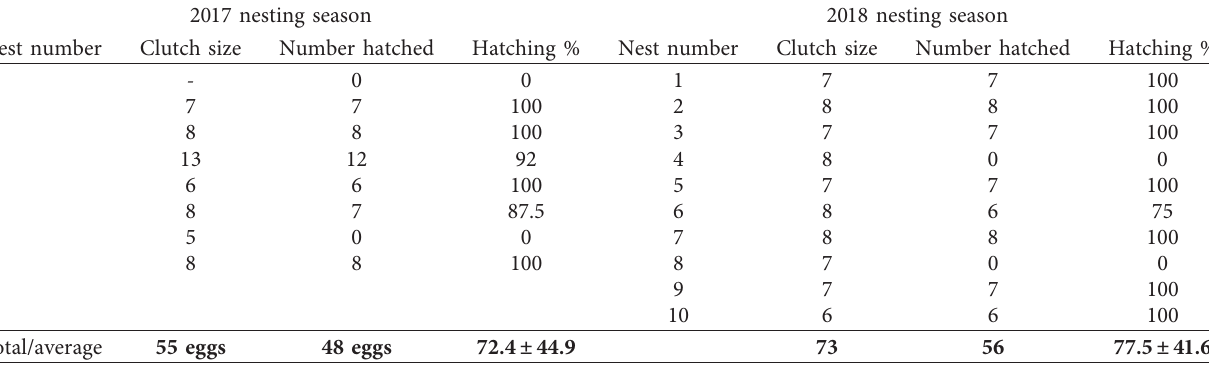
Table 4: Hatching success of West African dwarf crocodiles across two nesting seasons (2017 and 2018) in the Chirehin Community Land.